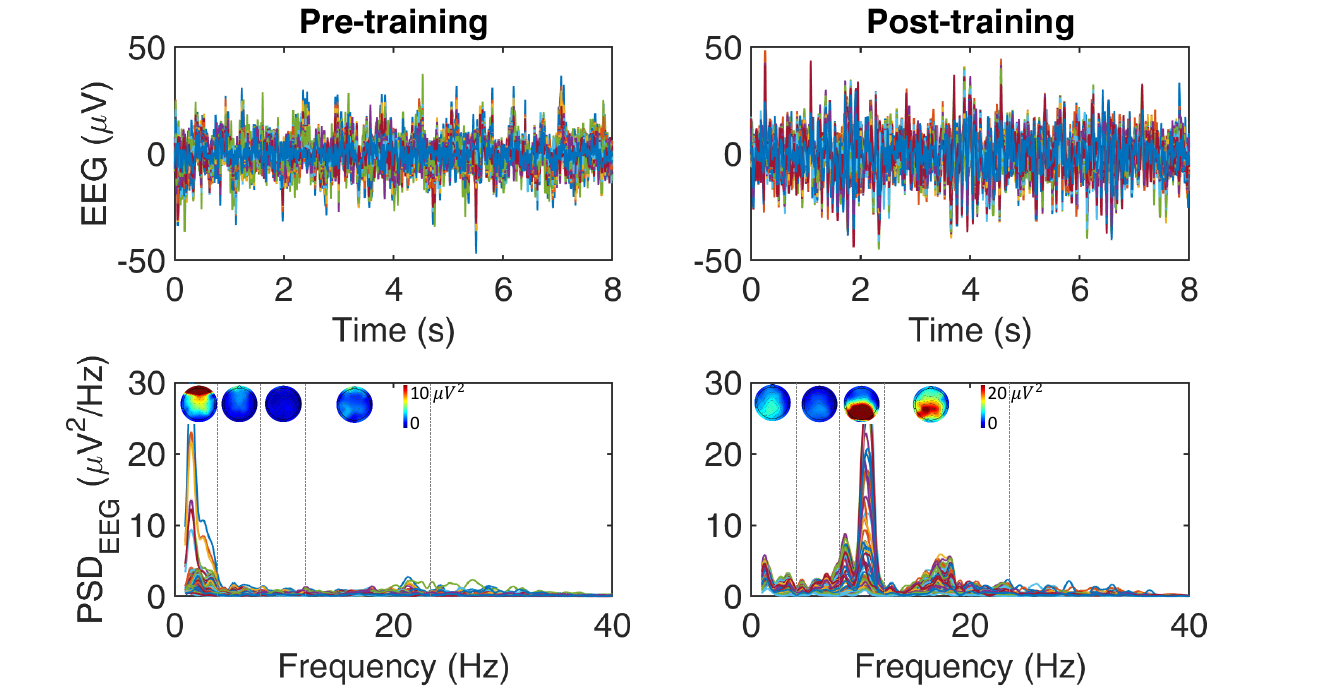
Figure 3. Example of filtered (in [1–40] Hz) EEG time series pre- (first column) and post- (second column) training with EKSO in a control subject. In the first row, it is reported 8 s of the EEG time-series. In the second row, it is displayed the power spectral density (PSD) computed between 1 and 40 Hz of the signals reported above. PSD was computed for the EEG signal recorded in each electrode using Welch’s 50% overlapped 2-s segment averaging estimator. For each EEG frequency band (i.e., Delta (1–4) Hz), Theta (4–8) Hz, Alpha (8–12) Hz, Beta (12–24) Hz), it is also reported the topographic map of the power